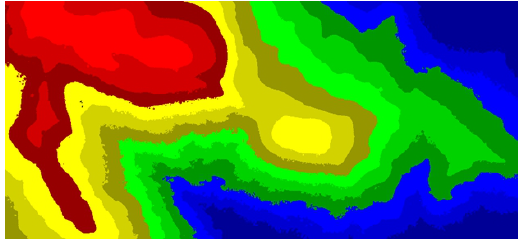
Figure 2. Original point cloud